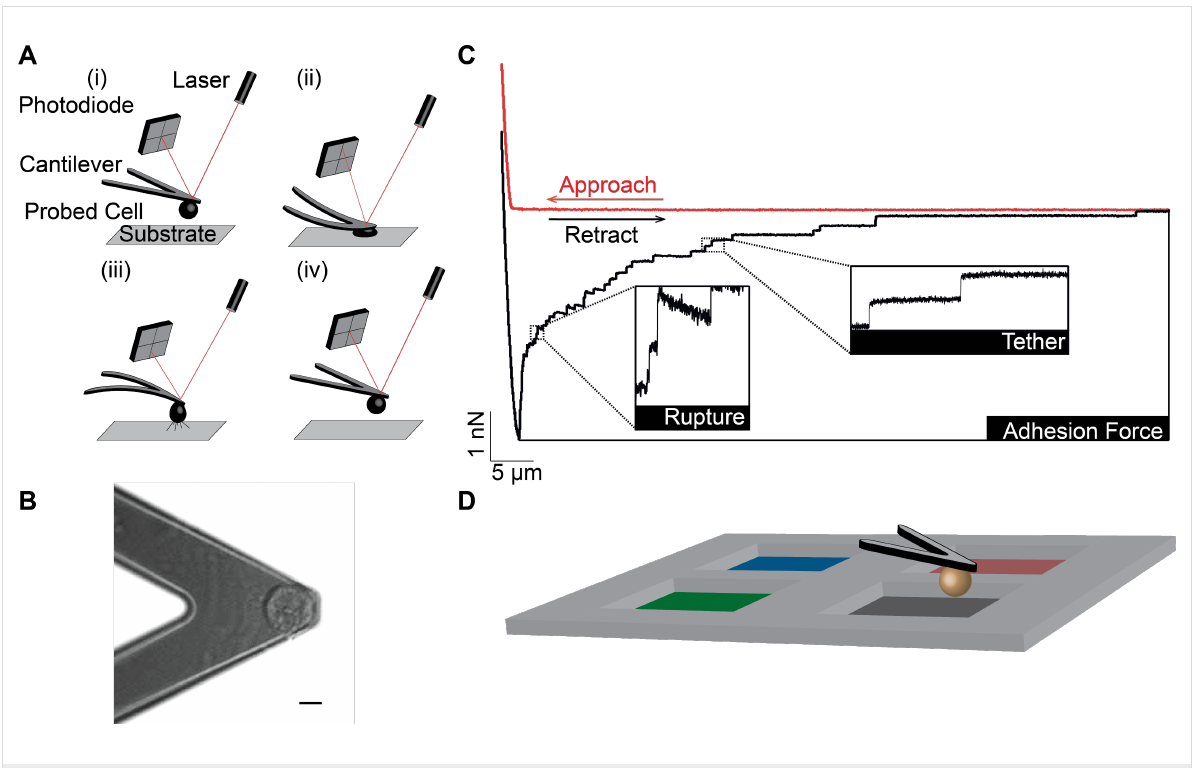
Figure 1: Depiction of AFM-based SCFS. (A,B) A single cell is bound to a tip-less AFM cantilever via a receptor specific or unspecific substrate (scale bar, 10 µm). (A) (i and ii) The cantilever-bound cell is brought into contact with the substrate until a preset force is recorded. After a specified contact time, (iii) the cantilever is retracted until the cell is fully detached from the substrate. During the experimental cycle, the deflection (force) of the cantilever and the distance between cell and surface is recorded in a force–distance curve (red). (C) The force–distance curve shows distinct features: In the approach segment of the force–distance curve, the deflection of the cantilever is recorded while the cell is lowered onto the substrate; the retraction segment of the force–distance curve (black) records the adhesion force of the cell, which is the maximum force acting on the cantilever and, thus, the force needed to initiate the detachment of the cell from its substrate. Subsequently, single receptor unbinding events are observed. Rupture events are recorded when the CAM–ligand bond of a cytoskeleton-linked CAM fails. Tether events are recorded when a membrane tether is extruded from the cell membrane with the CAM at its tip (tethers). In the latter case, attachment of the CAM to the cytoskeleton is either too weak to resist the mechanical stress applied or non-existent. (D) To improve the throughput of SCFS experiments, a four-segmented coating mask is used, allowing adhesion force measurements of one cell to different adhesives